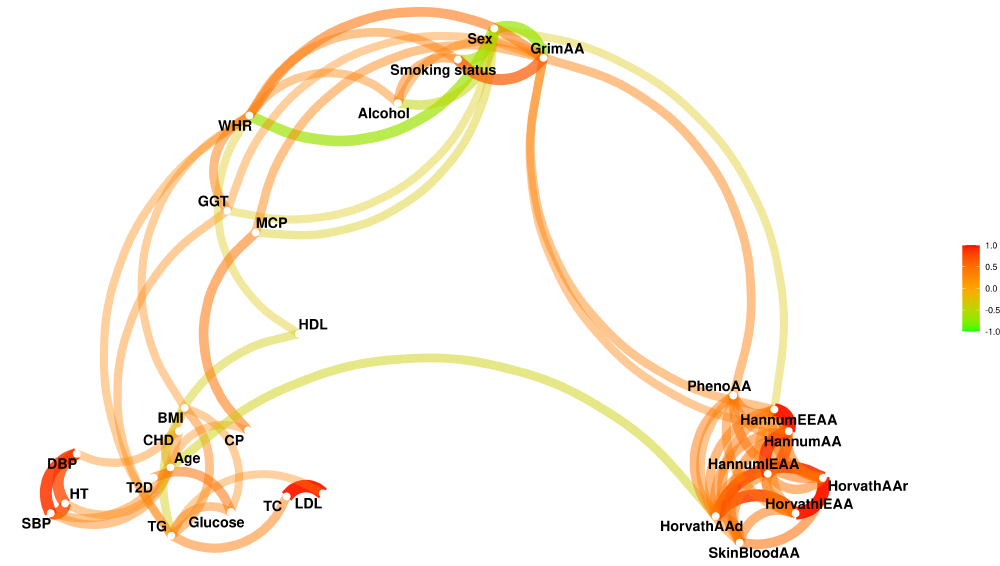
Figure 2. Network plot of of the connections among the phenotypes and EAAs in the dataset, based on Spearman correlation coefficients with absolute values above